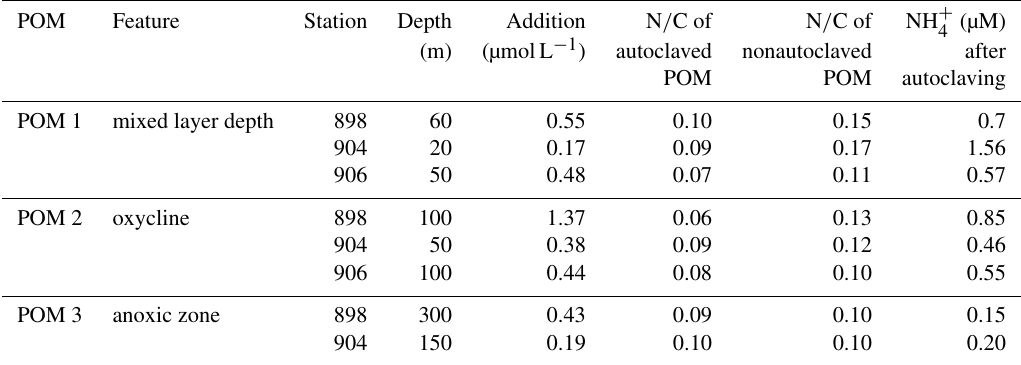
Table 2. Quality (N / C), quantity (addition µmolL − 1 ) and origin (station and depth) of added, autoclaved and nonautoclaved particulate organic matter (POM) and increase in NH + concentration after autoclaving. 4